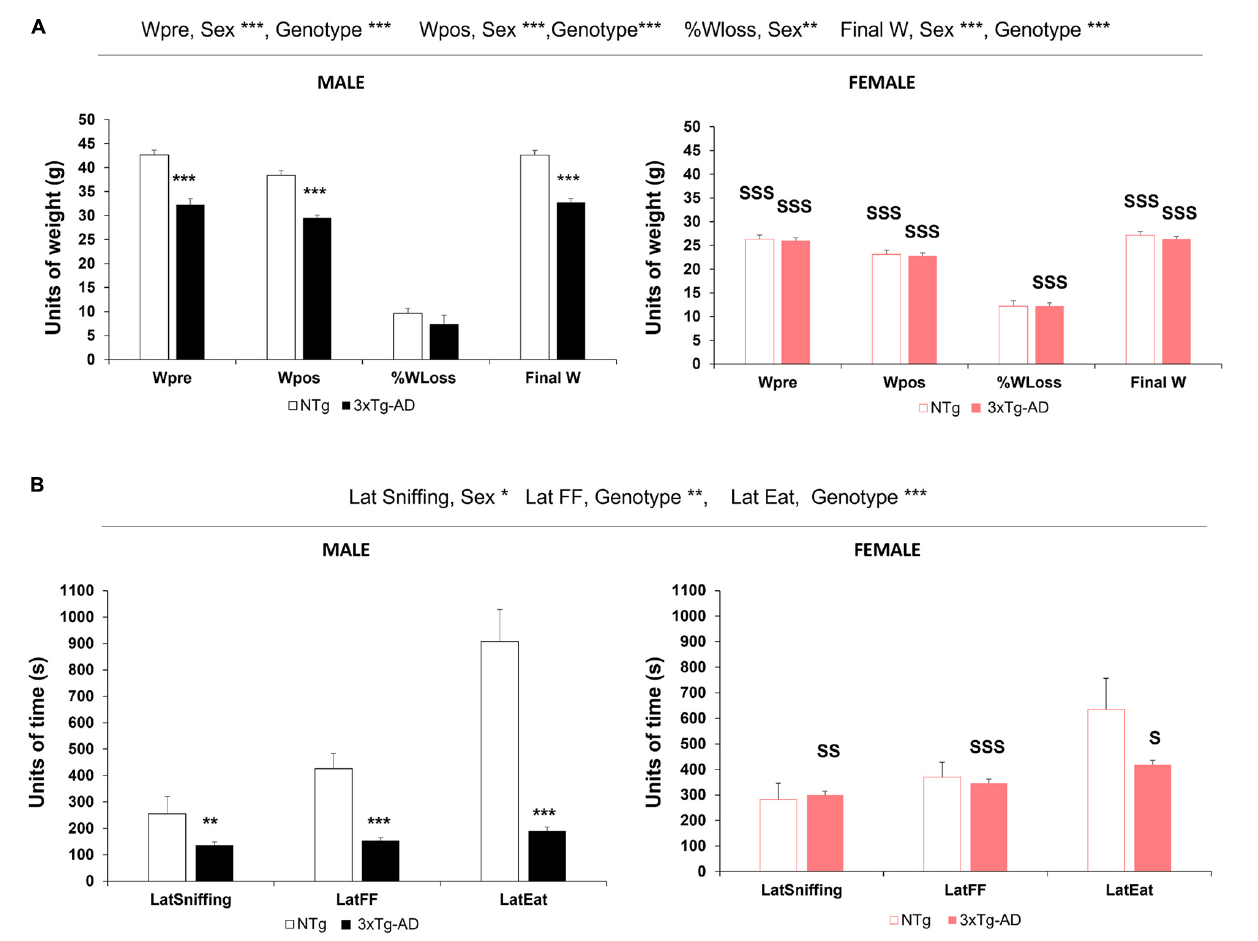
FIGURE 1 | Genotype and sex differences in body weight monitoring and food finding test in 13-month-old NTg and 3xTg-AD mice. The results are expressed as mean ± SEM. (A) Food deprivation: Wpre, initial weight before fasting; Wpost, weight after fasting;%Wloss, percent of weight lost overnight; Final W, final weight at 24 h later. (B) Food finding test—latencies in the food finding test: LatSniffing, latency to sniffing the hidden pellet; LatFF, latency to find the food (hidden pellet); LatEat, latency to eat the pellet. Statistics: ** p < 0.01, ***p < 0.001 vs. NTg mice of the same sex; S, p < 0.05; SS, p < 0.01; SSS, p < 0.001 vs . male of the same